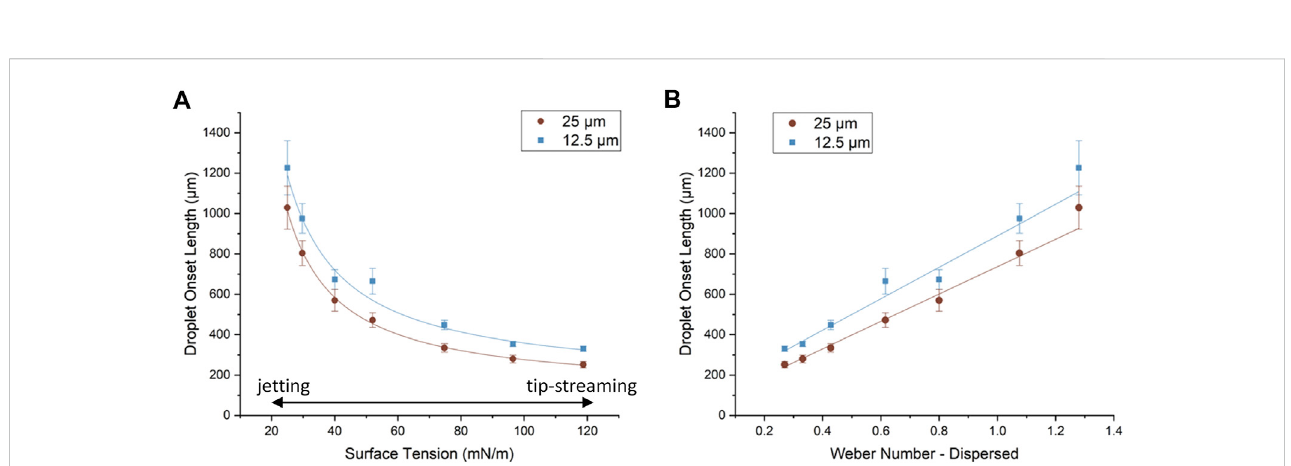
FIGURE 3 Droplet breakup length as a function of (A) σ 0 and (B) the Weber number of the dispersed phase (We d ) for neck widths of 12.5 and 25 µm. Note that dropletonsetlengthappearsinverselycorrelatedwithinitialsurfacetension.Theerrorbarsarethestandarddeviation.Resultsaremostcloselyassociatedwith the “ jetting ” and “ tip-streaming ” regimes, withlowersurfacetensions tendingtoresemblejetting andhigher surfacetensionsimulations beingmore similarto tip-streaming (see